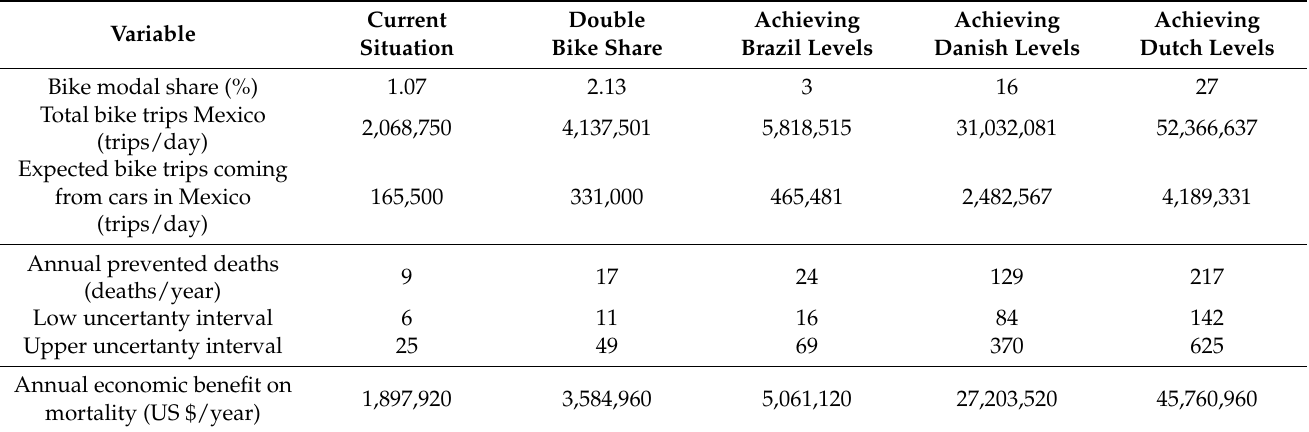
Table 2. Results of current and hypothetical bicycling scenarios in Mexico.